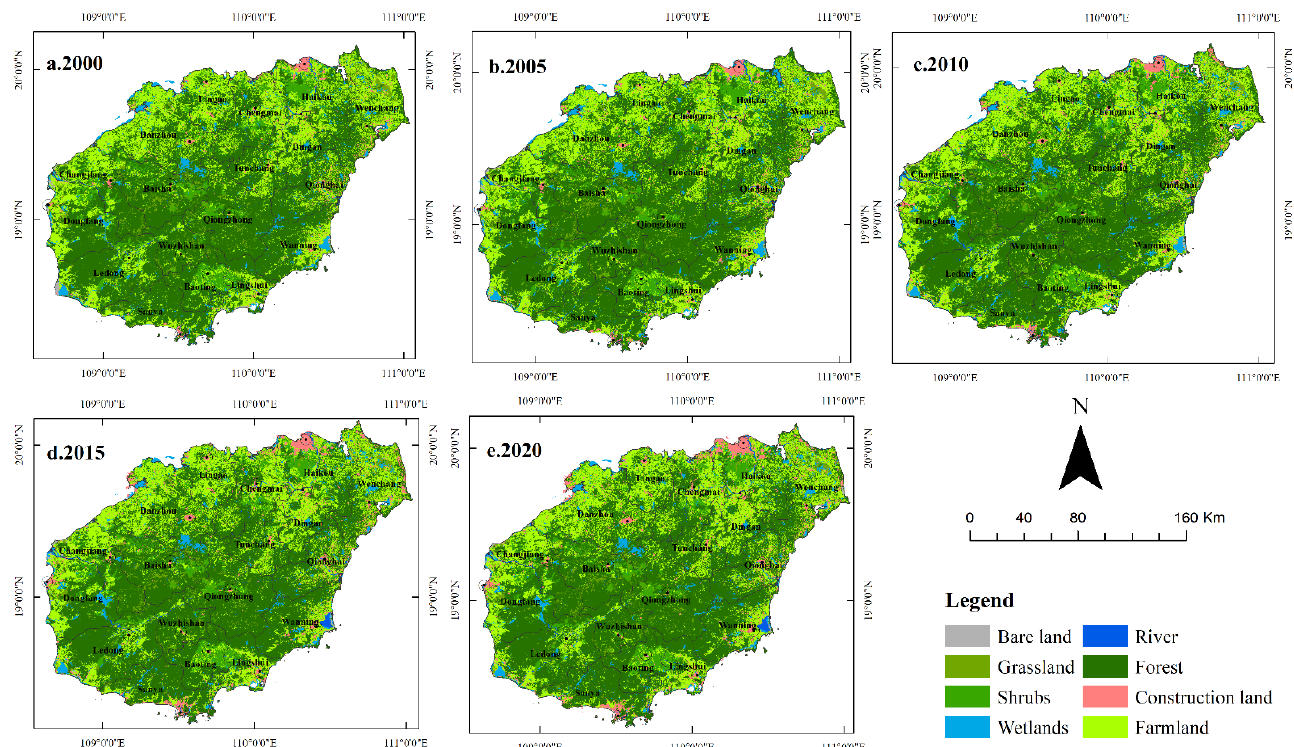
Figure 2. Spatial pattern of ecosystems in Hainan Province from 2000-2020. Note: (a) spatial pattern of ecosystems in Hainan Prov- 231 Figure 3. Spatial pattern of ecosystems in Hainan Province from 2000 to 2020. Note: ( a ) spatial pattern of ecosystems in Hainan Province in 2000; ( b ) spatial pattern of ecosystems in Hainan Province in ince in 2000; (b) spatial pattern of ecosystems in Hainan Province in 2005; (c) spatial pattern of ecosystems in Hainan Province in 232 2005; ( c ) spatial pattern of ecosystems in Hainan Province in 2010; ( d ) spatial pattern of ecosystems in 2010; (d) spatial pattern of ecosystems in Hainan Province in 2015; and (e) spatial pattern of ecosystems in Hainan Province in Hainan 233 Hainan Province in 2015; and ( e ) spatial pattern of ecosystems in Hainan Province in 2020. Province in 2020. Table 6. Areas and percentages of different ecosystem classes in Hainan from 2000 to 2020.